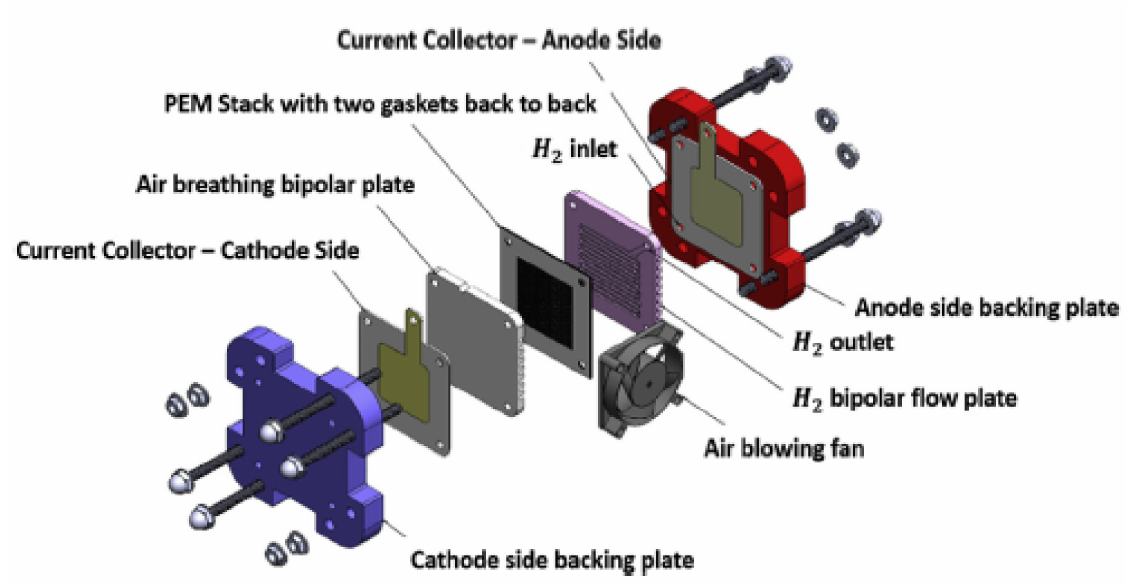
Figure 1. Exploded view of a single PEM fuel cell [6].